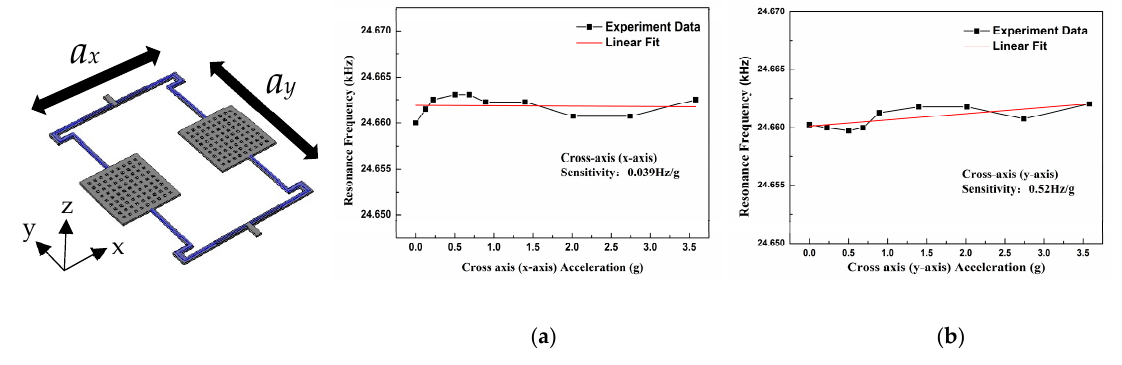
Figure 11. Cross axis sensitivities of the AlN MEMS accelerometer. ( a ) X-axis sensitivity; ( b ) y-axis sensitivity.